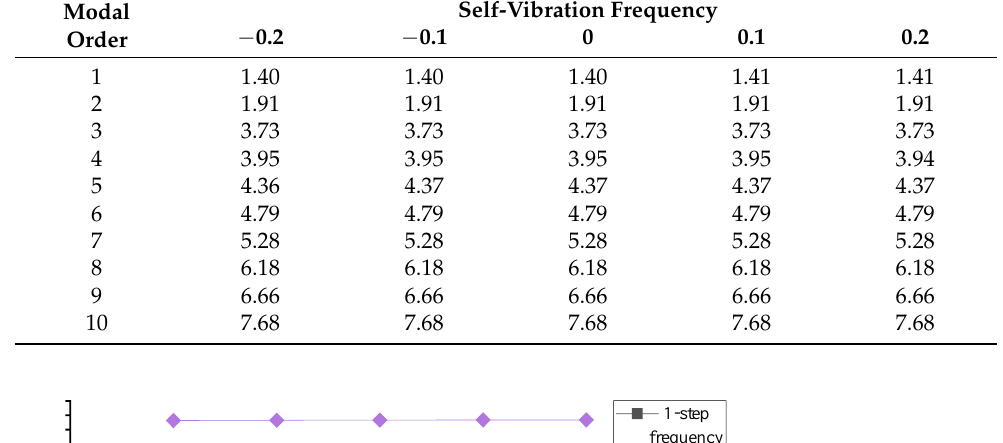
Table 3. Self-vibration frequencies (Hz) for different beam heights of the original structure. Modal Order